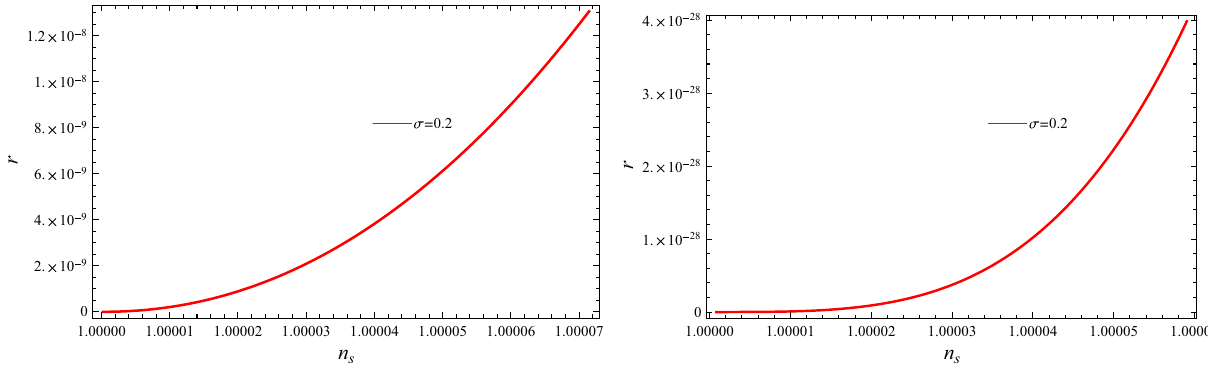
1.00000 1.00001 1.00002 1.00003 1.00004 1.00005 1.00006